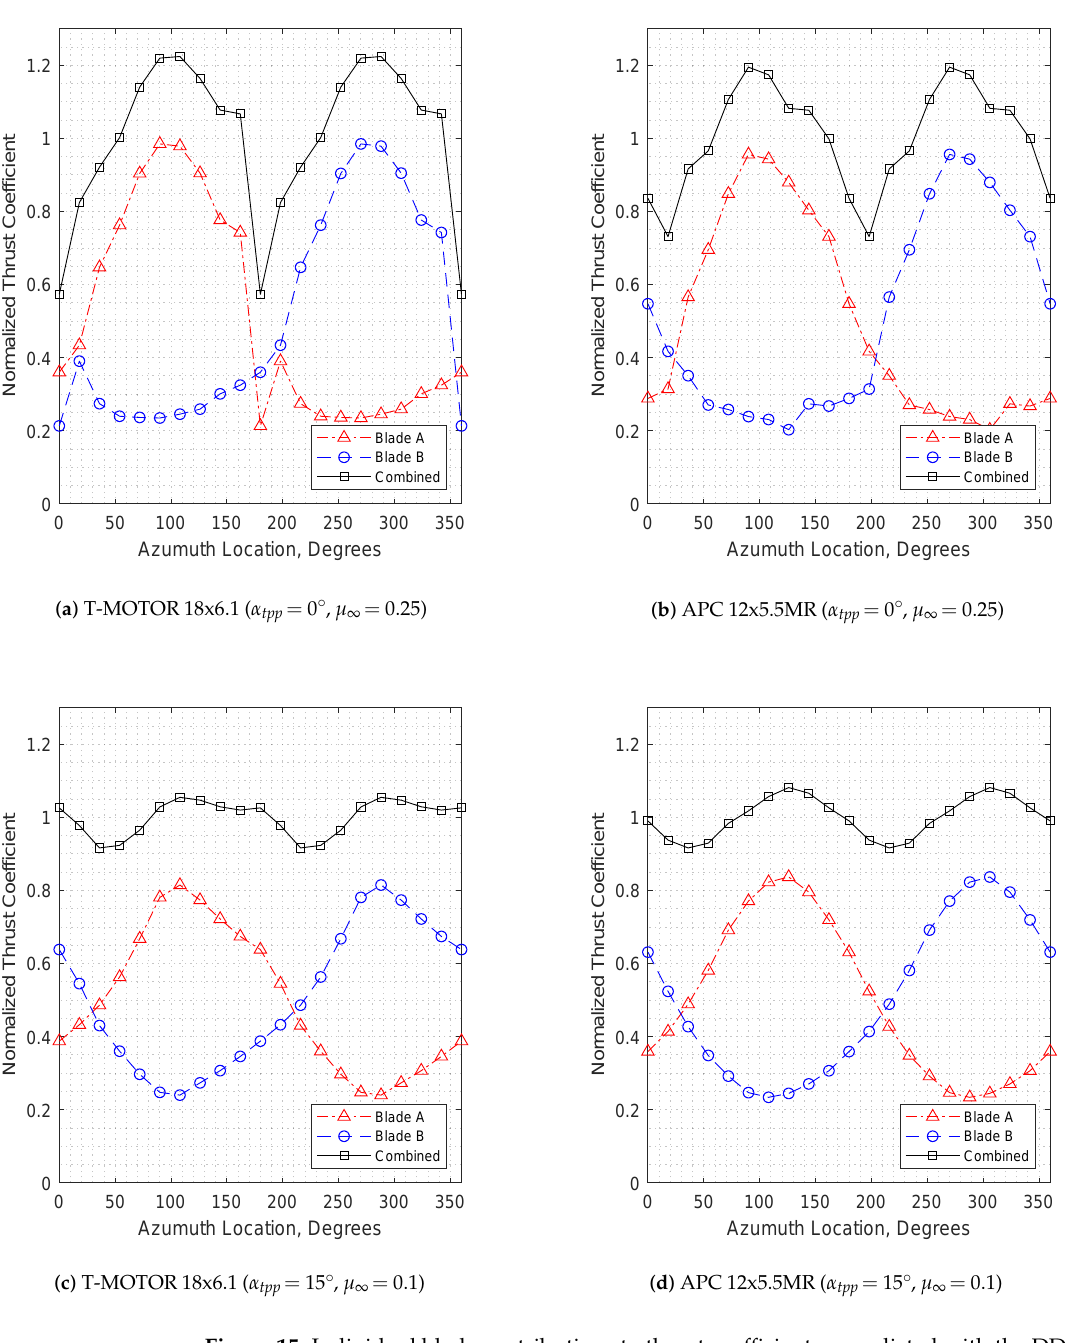
Figure 15. Individual blade contributions to thrust coefficient as predicted with the DDE method.